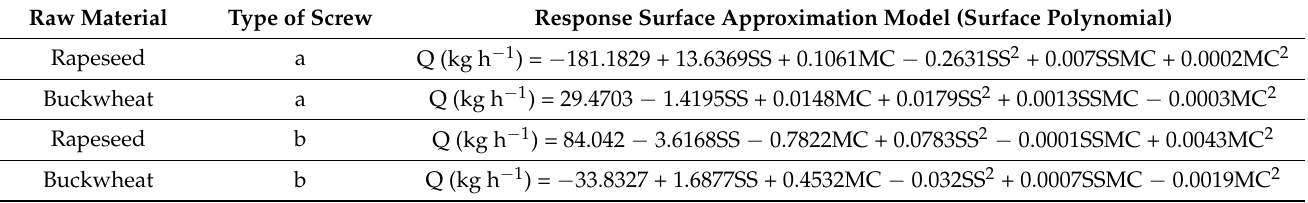
Table 1. Models of response surface approximation for the efficiency of extrusion-cooking of rapeseed and buckwheat straws depending on the process